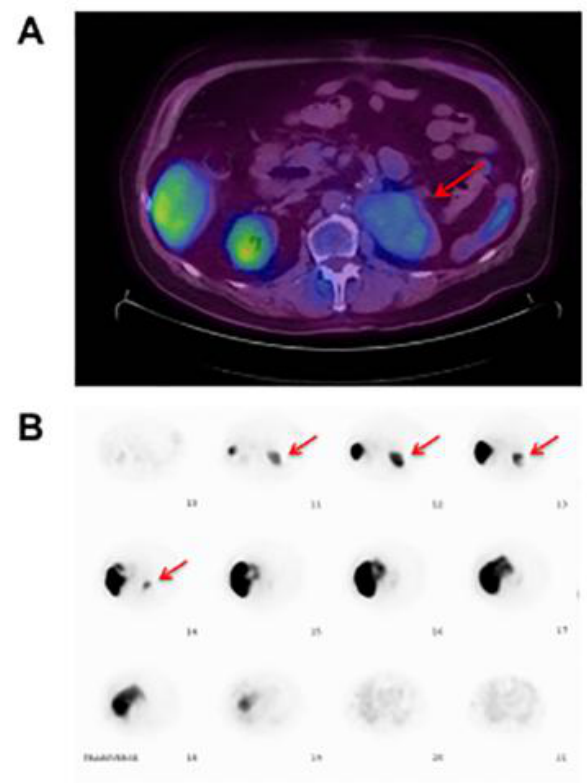
Figure 2. A. Axial fused PET/CT image demonstrating an 8.5 x 6.5 cm soft tissue mass in the left renal fossa (red arrow) with mild FDG uptake. There is physiologic FDG uptake in the liver, bowel, and right kidney. B. Transverse Tc-99m sulfur colloid scintigram showing uptake by the liver and spleen (red arrow), with the latter located in the left renal